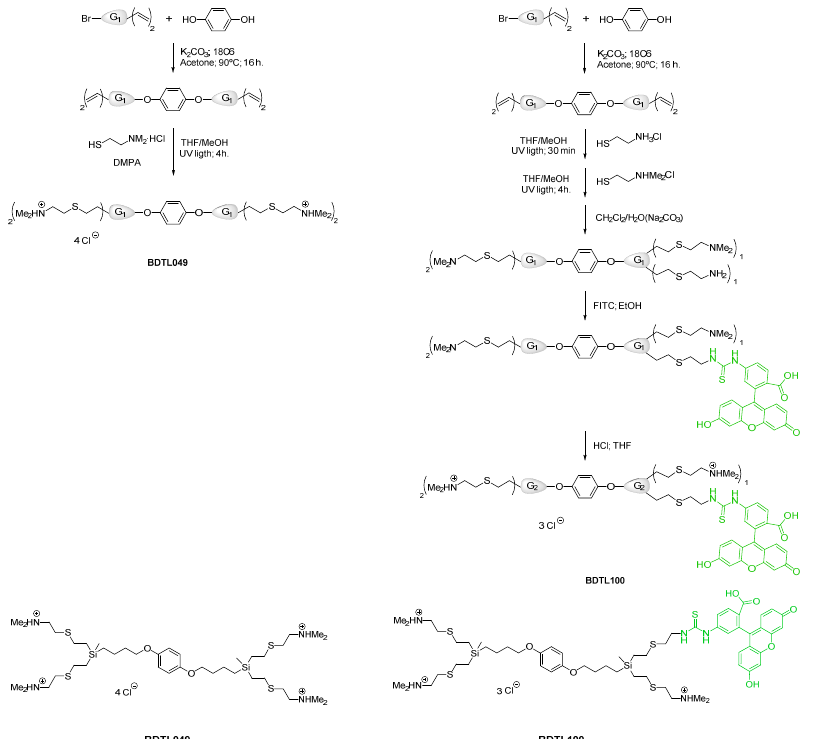
Figure 1. Synthesis and structure of the cationic carbosilane derivatives used in this study. Upper-left, the synthetic procedure for the formation of compound BDTL049 as previously described [18]. Upper-right, the synthetic procedure for the formation of the green-fluorescently labeled form BDTL100. The final chemical structures of the original BDTL049 and derivative compound BDTL100 are shown in the lower panel.